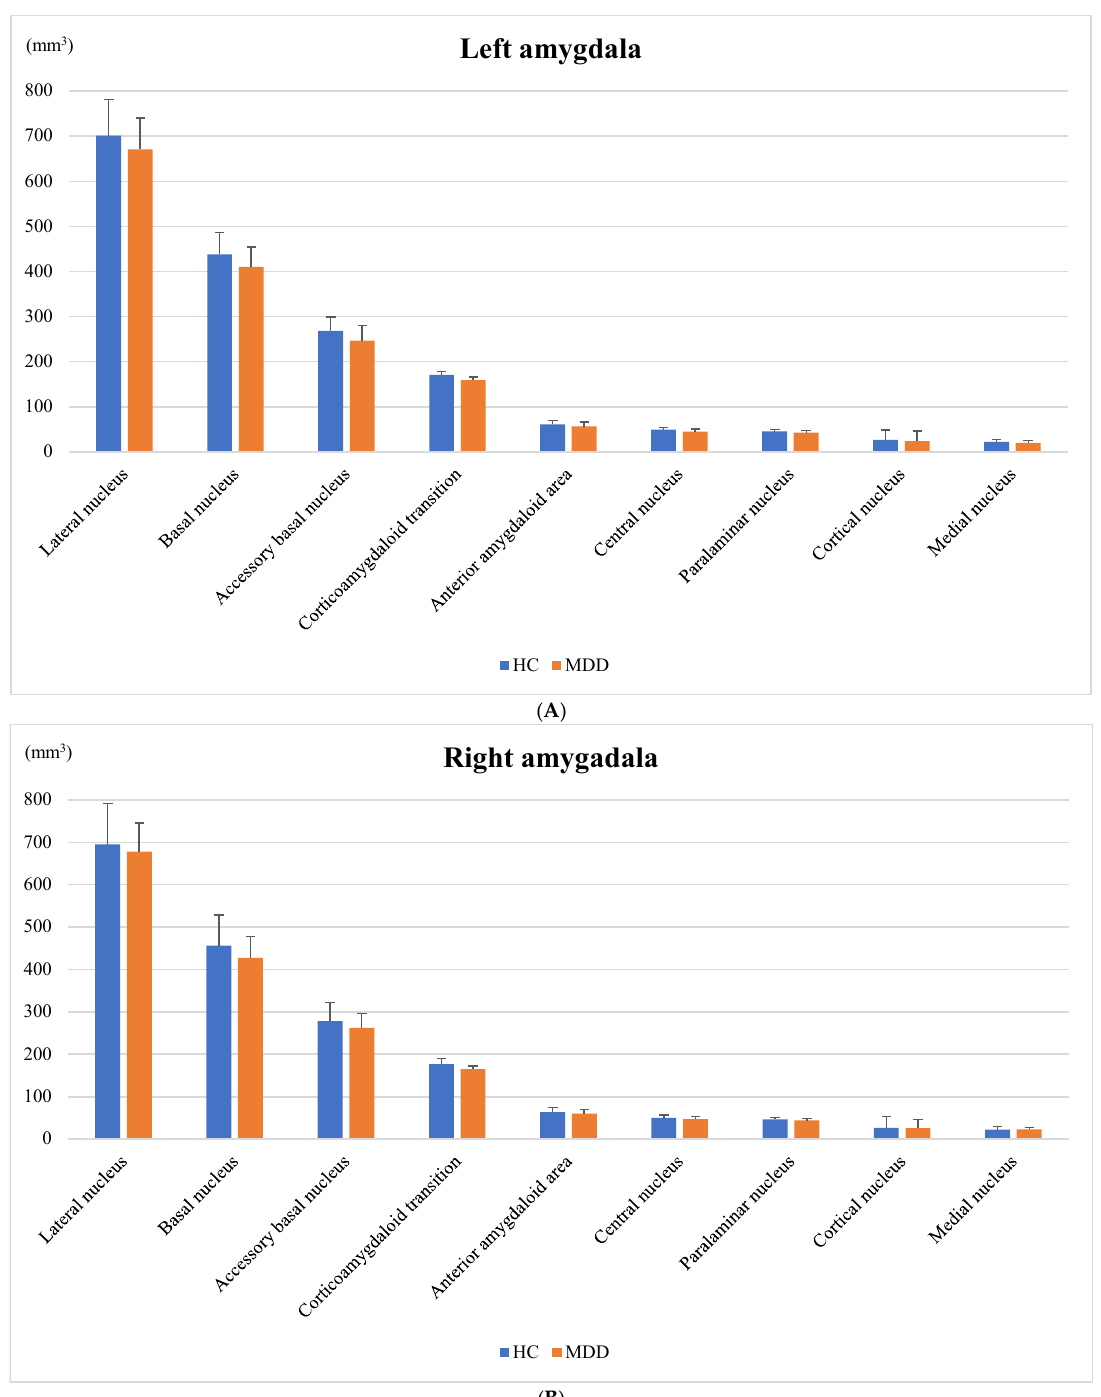
Figure 2. Subregion volumes in the left ( A ) and right ( B ) amygdala. ( A ) Subregion volumes in the left amygdala. Bar charts show the mean amygdala subfield volumes (mm 3 ) of HCs (blue) and patients with MDD (orange). The vertical bars indicate standard deviations. Linear regression analyses showed no significant difference in all subfields between HCs and MDD patients adjusted for estimated total intracranial volume, age, and sex; ( B ) Subregion volumes in the right amygdala. Bar charts show the mean amygdala subfield volumes (mm 3 ) of HCs (blue) and MDD patients (orange). The vertical bars indicate standard deviations. Linear regression analyses showed no significant difference in all subfields between HC and MDD groups adjusted for estimated total intracranial volume, age, and